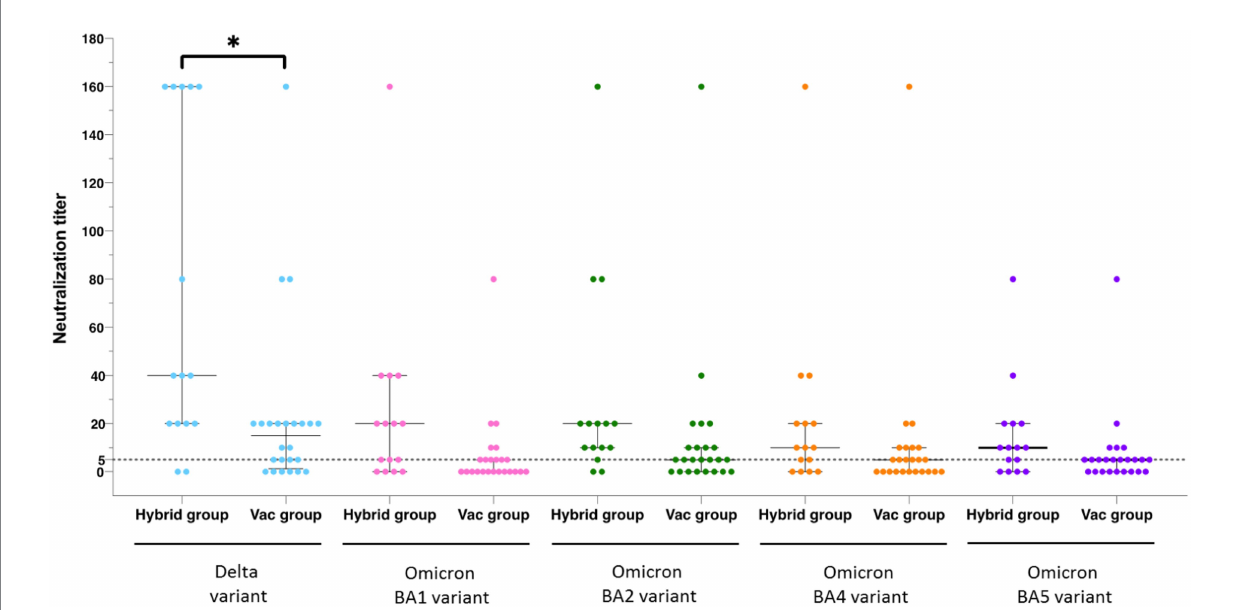
FIGURE 5 Neutralization titers in the Hybrid group and the Vac group according to the SARS-CoV-2 variants. Neutralization titers were compared for each variant between the Hybrid group, formed of kidney transplant recipients immunized against SARS-CoV-2 by vaccination and prior COVID-19, and the Vac group, formed of patients immunized only by vaccination, using one-way ANOVA followed by Tukey’s multiple comparison test; * p < 0.05.